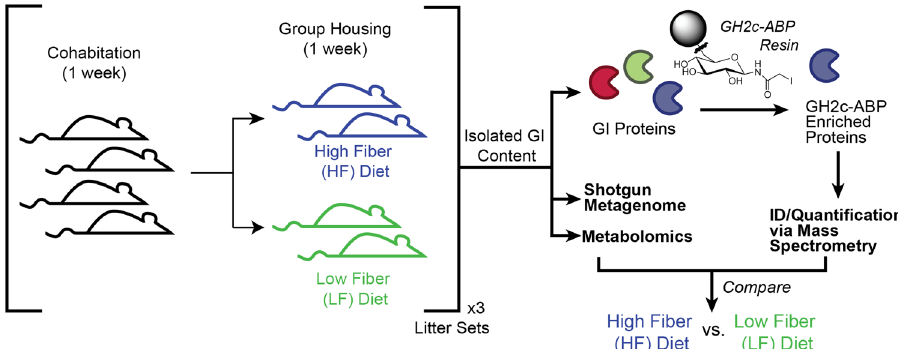
Fig. 1 Experimental design for functional resolution of the microbiome response to altered fi ber diets. Four littermates were cohabitated for 1 week before splitting into high fi ber (HF) and low fi ber (LF) littermate pairs. After 1 week, GI content was investigated with ABPP and multi-omics analyses. A GH2c-ABP linked resin was used to enrich proteins with metabolic or transport activities for sugar moieties from the GI proteome. Enriched proteins were then identi fi ed and quanti fi ed using mass spectrometry. The gut metagenome for each mouse was obtained via shotgun sequencing. Metabolites were analyzed via mass spectrometry. Omics measurements for the HF and LF groups were then